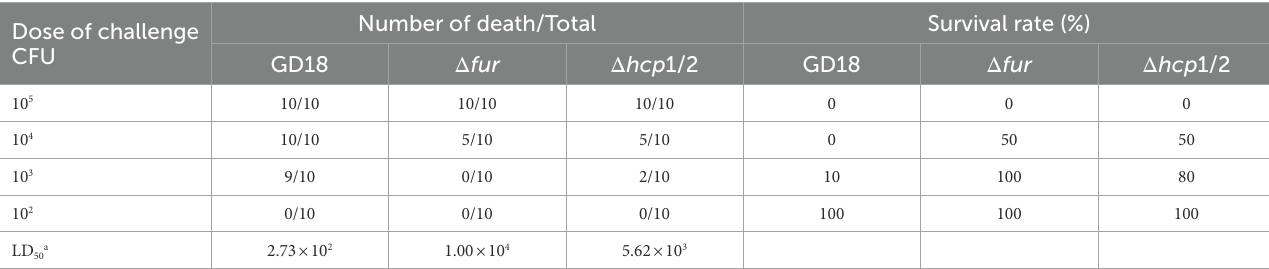
TABLE 3 Calculations of LD 50 s of the A. hydrophila GD18 and mutant strains in zebrafish. Dose of challenge